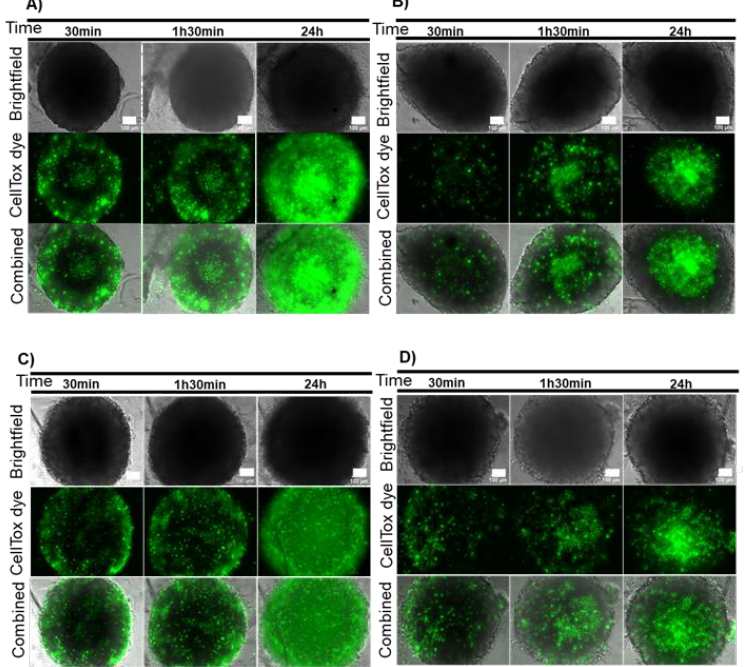
Figure 2. Combined e ff ect of AuNP@PEG and irradiation on cell viability measured by CellTox green. ( A ) HCT116 spheroids incubated for 24 h with 8 nM AuNP@PEG and then irradiated with a 532-nm green laser for 1 min; ( B ) HCT116 spheroids irradiated with a 532-nm green laser for 1 min; ( C ) Doxorubicin-resistant HCT116 (HCT116-DoxR) spheroids incubated for 24 h with 8 nM AuNP@PEG and then irradiated with a 532-nm green laser for 1 min; ( D ) HCT116-DoxR spheroids irradiated with a 532-nm green laser for 1 min. Microscopy images were acquired in Brightfield or with a green fluorescence filter to evaluate CellTox green dye fluorescence, after 30 min, 1 h 30 min or 24 h incubation. The combined images result from the overlap between Brightfield and green filter images. Scale bar corresponds to 100 µ